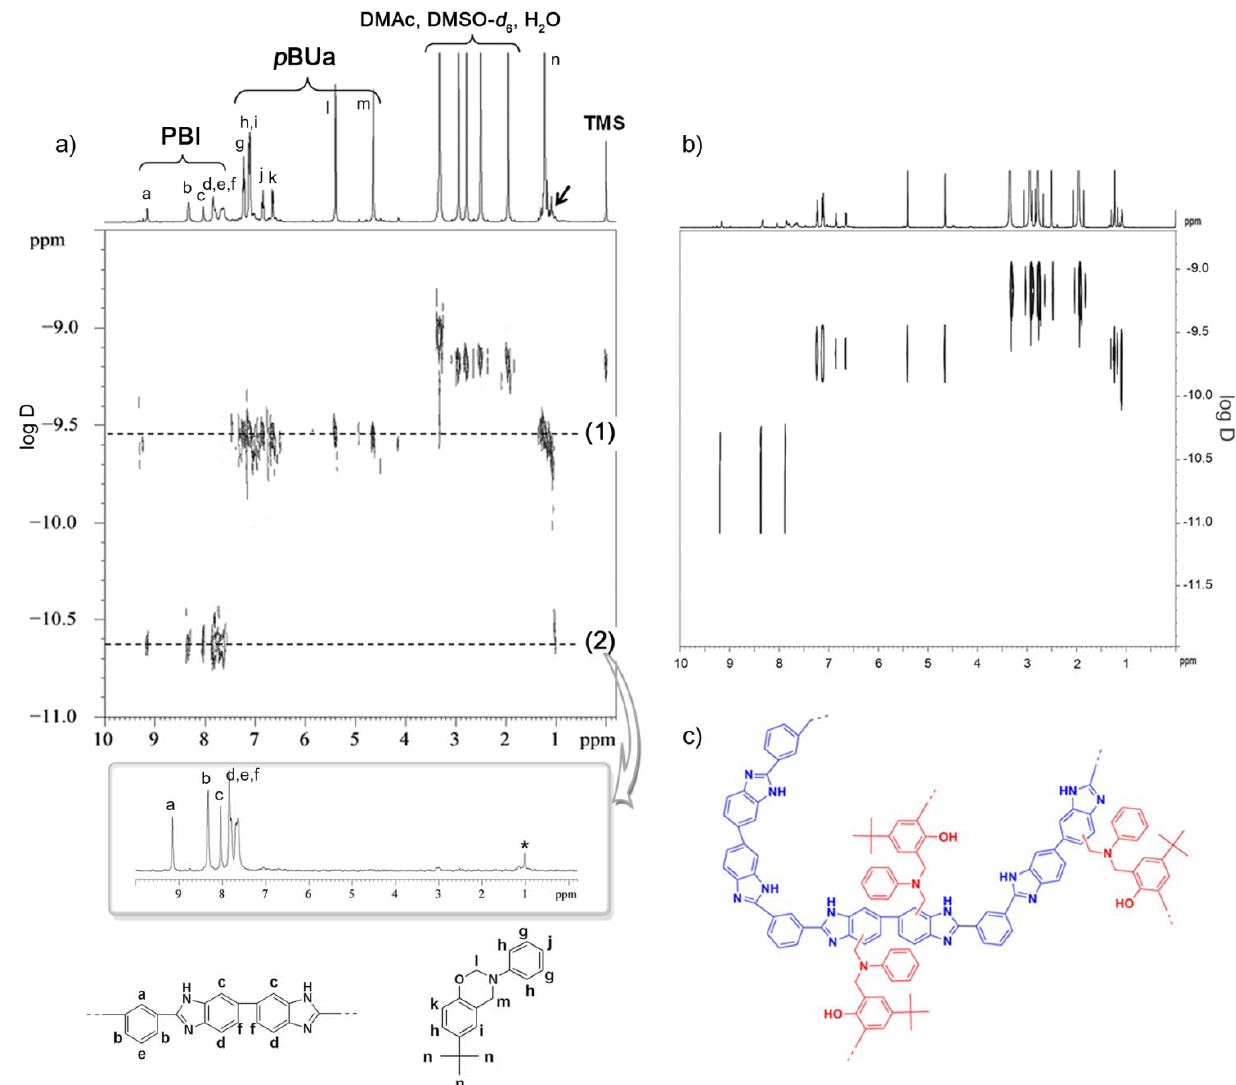
Figure 4. 2D diffusion ordered spectroscopy (DOSY) NMR spectra of ( a ) p BUa and PBI mixture ( p BUa:PBI = 65:35 (wt %)) obtained at 140 °C for 30 min, (inset) 1D slice 1 H NMR spectrum at ca. − 10.6 ppm; and ( b ) mixture of p BUa obtained at 140 °C for 1 h